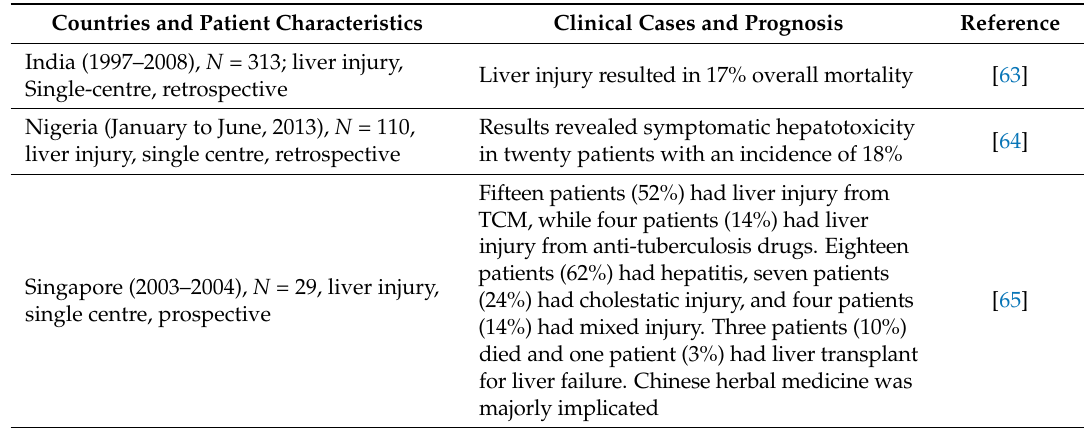
Table 1. Selected clinical case reports of DILI in developing